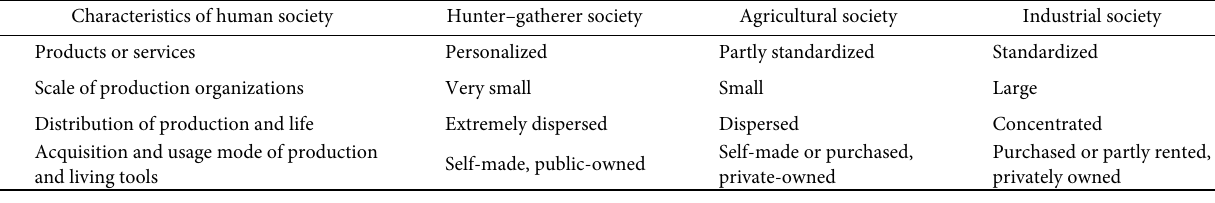
Table 1 Review of the evolution of human